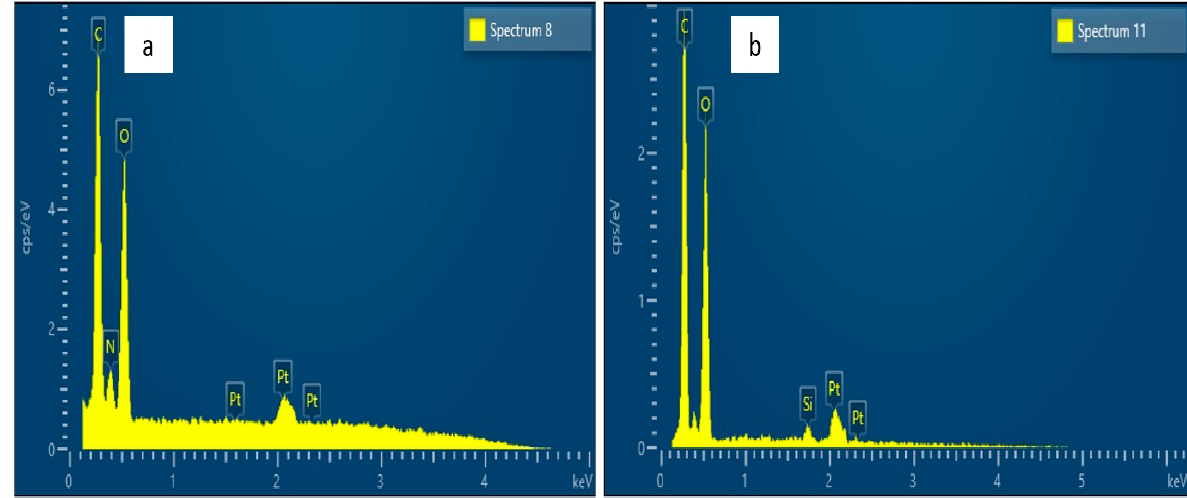
Figure 6. Elemental analysis of the OPF ( a ) and OPF-S ( b ).